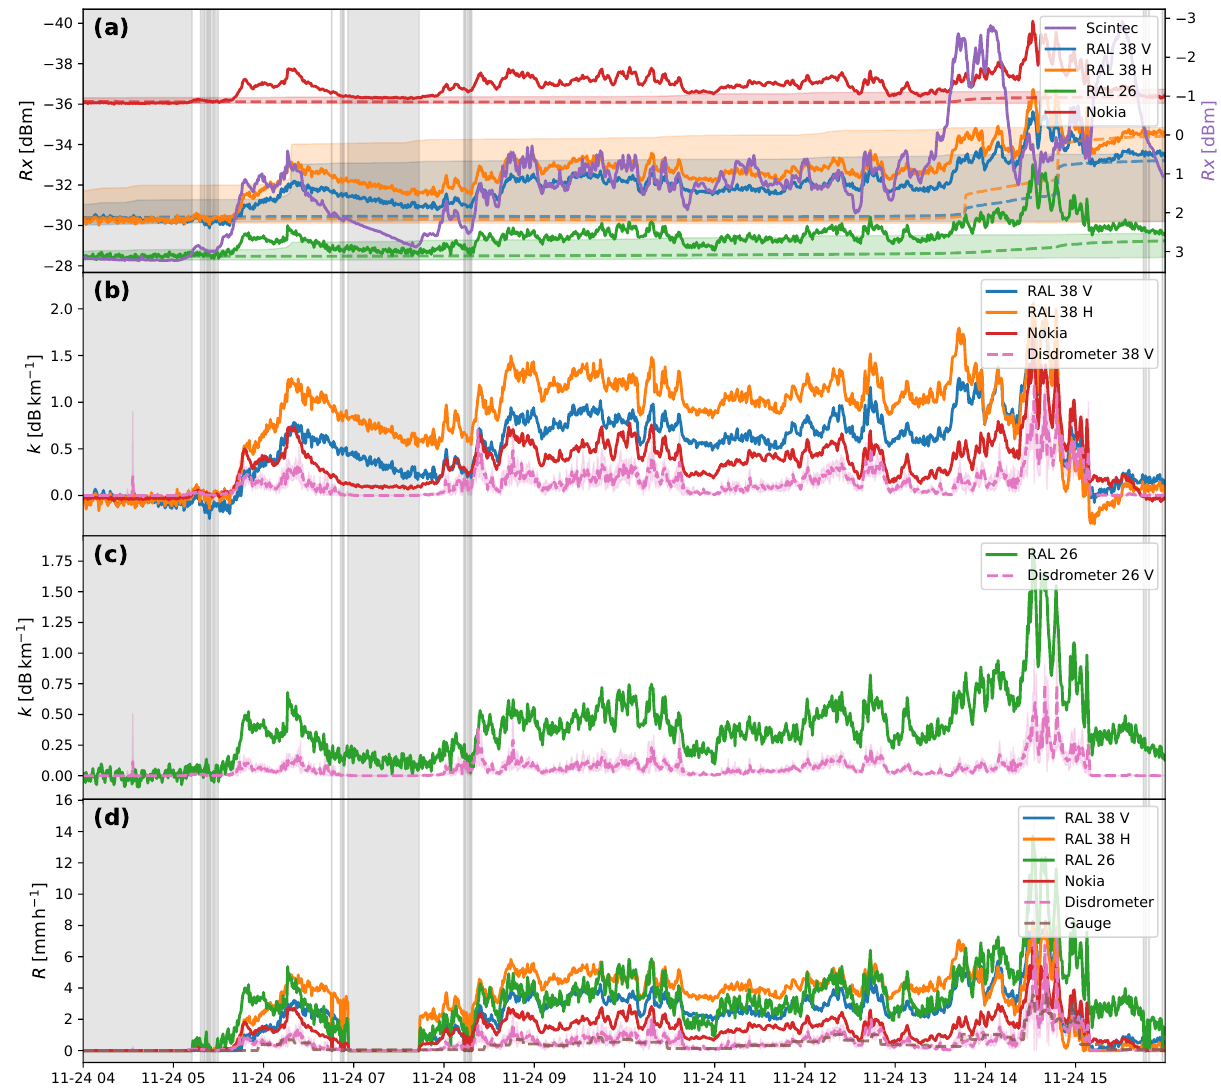
Figure 6. Time series of an event on 24 November 2015. (a) Received power levels (solid lines) and reference levels (median over dry periods in a 24h moving window: dashed lines). The 5th and 95th percentile power levels over dry periods in a 24h moving window are indicated by the coloured shading. (b) Specific attenuation of the 38GHz links derived using the reference levels as well as the theoretical specific attenuation at 38GHz derived from the disdrometers. Both the weighted spatial average (dashed line) and weighted spatial standard deviation (shaded area) are shown. Panel (c) is the same as (b) , but for 26GHz. (d) Rainfall intensities derived from the link attenuations using the R – k power law and rainfall intensities derived from the disdrometers. Both the weighted spatial average (dashed line) and weighted spatial standard deviation (shaded area) are shown. The rainfall intensities derived from the tipping bucket gauge are indicated with the brown dashed line. Dry periods, as determined with the disdrometers, are represented by grey shaded